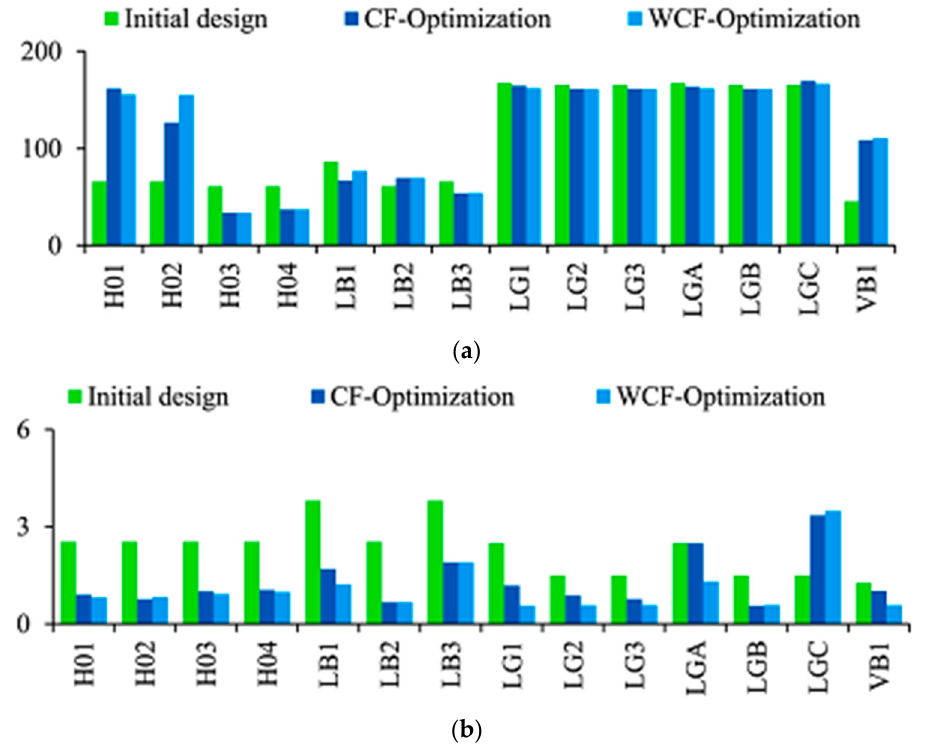
Figure 15. Comparison of various optimization methods with and without considering fatigue life criterion as the constraint [78]. ( a ) The outer diameter (cm), ( b ) The thickness (cm).